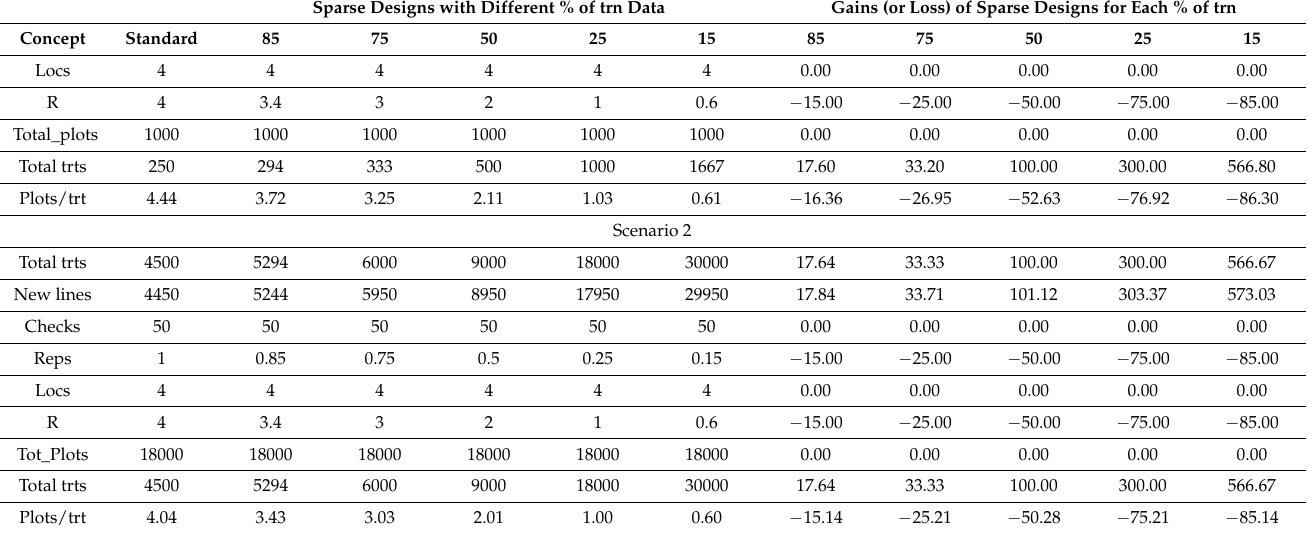
Table 1. Cont. Sparse Designs with Different % of trn